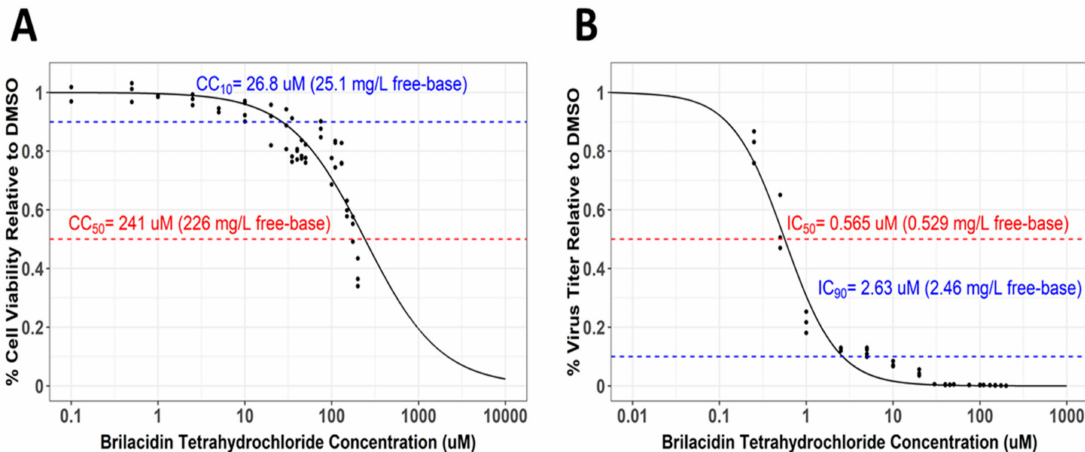
Figure 4. Brilacidin exhibits potent inhibition of SARS-CoV-2 in Calu-3 cells. ( A ) Calu-3 cells were treated at increasing concentrations of brilacidin at a range of 0.1–200 µ M. Cell viability was measured at 24 hpt and calculated versus the DMSO control as described in Materials and Methods. ( B ) Calu-3 cells were pretreated for 2 h with brilacidin at increasing concentrations, directly infected with treated (and preincubated) viral inoculum at MOI 0.1 at the indicated pretreatment brilacidin concentration for 1 h, and post-treated with media containing brilacidin as described in Materials and Methods. At 24 hpi, viral supernatants were evaluated by plaque assay as described in Materials and Methods. Graphs are representative of one independent experiment performed in technical triplicates ( n = 3). Sigmoidal Hill-type models as a function of brilacidin tetrahydrochloride concentration and were fit to the cell viability ( A ) and inhibitory response ( B ) data using nonlinear least-squares regression. The dashed lines indicate ( A ) derived cytotoxicity concentration (CC)10 and CC50 values, and ( B ) derived inhibitory concentration (IC)50 and IC90 values. The calculated Selectivity Index is 426 (CC50 = 241 µ M/IC50 = 0.565 µ